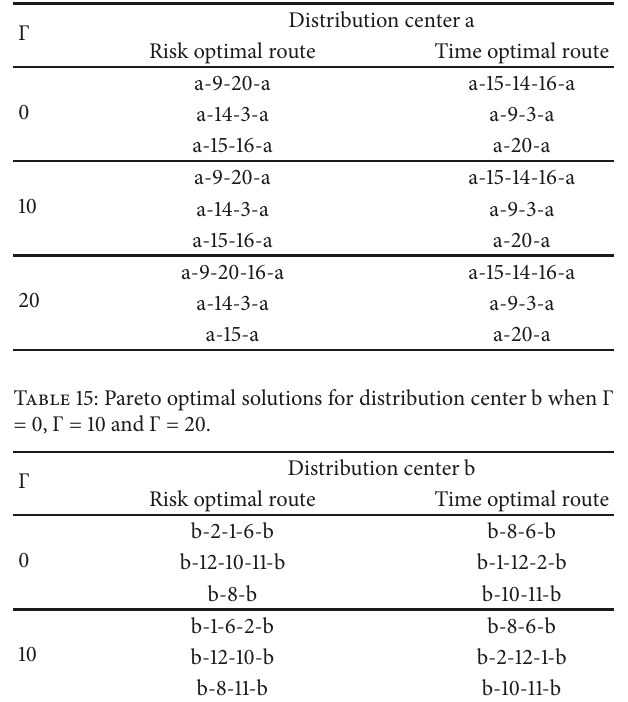
Table 17: Performance comparison between FCMC-PSO algorithm and